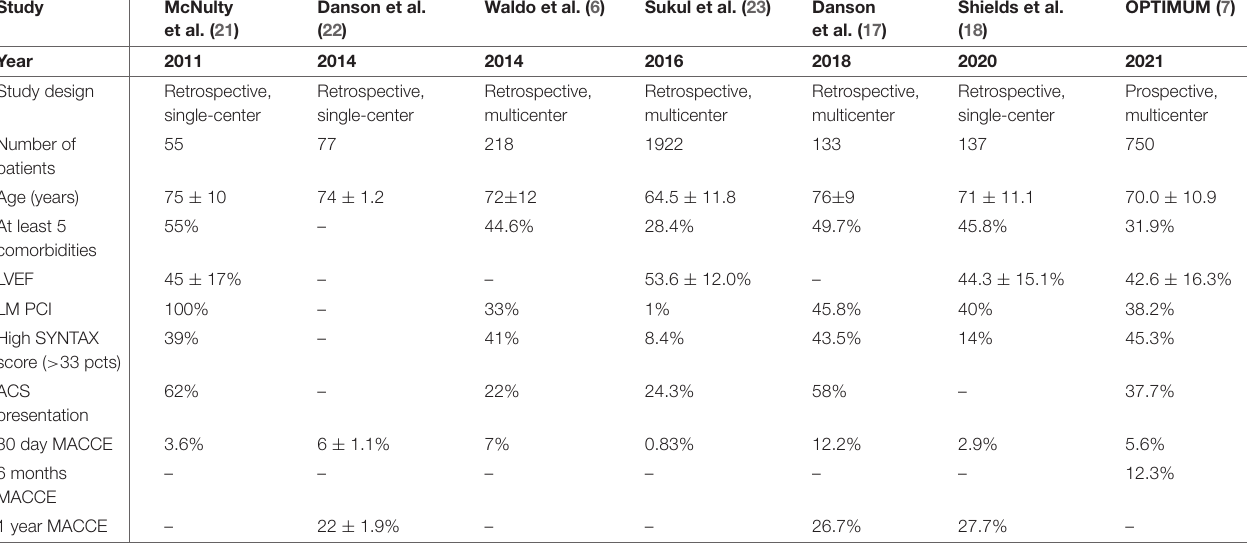
TABLE 1 | Distribution of percutaneously treated coronary artery disease in surgical turndowned patients, comorbidity and anatomical stratification − 6 studies across 10 years.